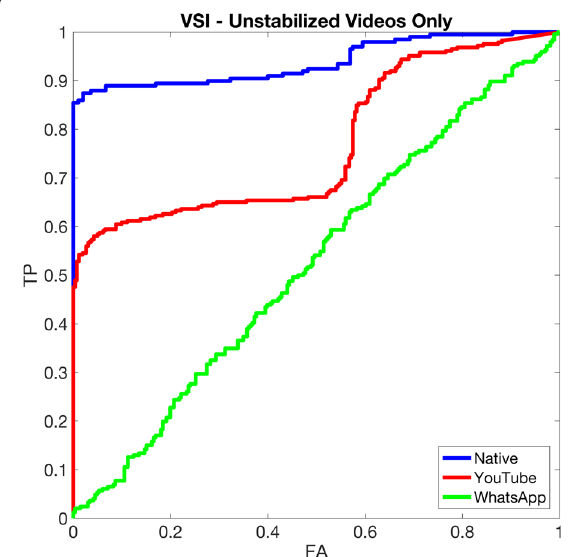
Fig. 4 (Bestviewed in colors) The VSI performance on Native, YouTube, andWhatsApp videos (in blue, red and green respectively) considering only devices devices without in-camera digital stabilization